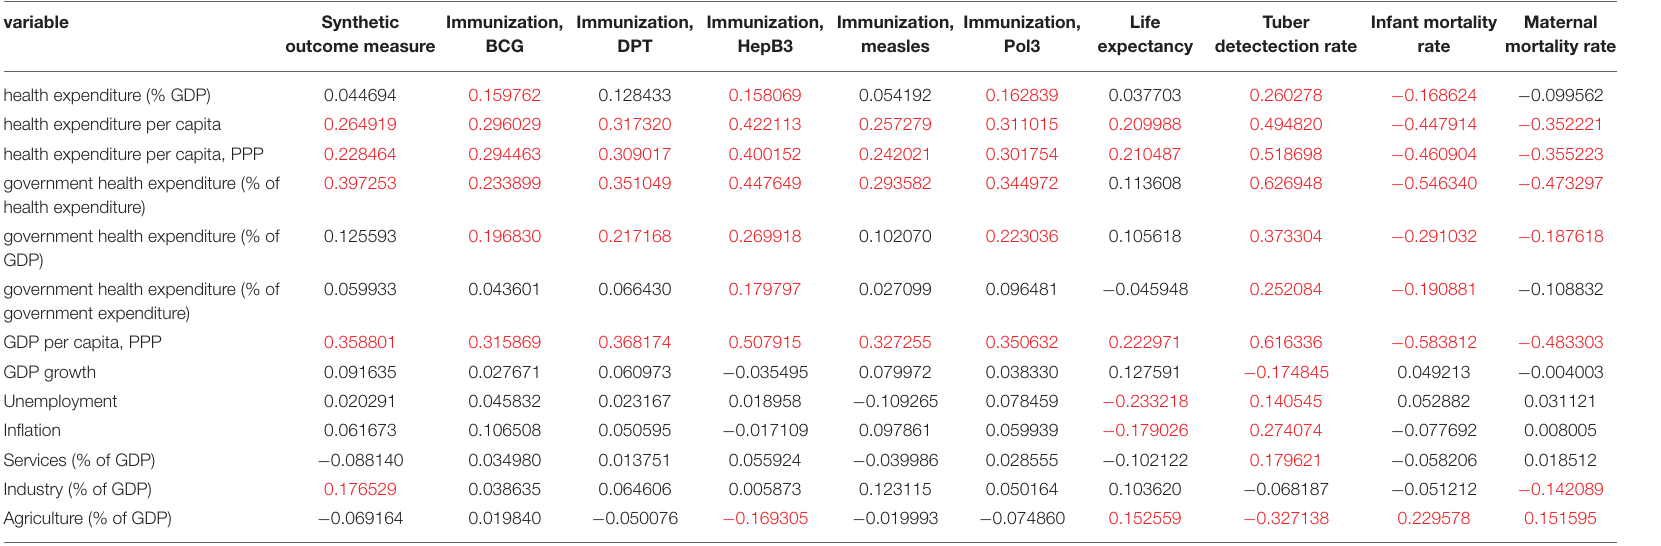
TABLE 3 | Correlation between health system performance and economic